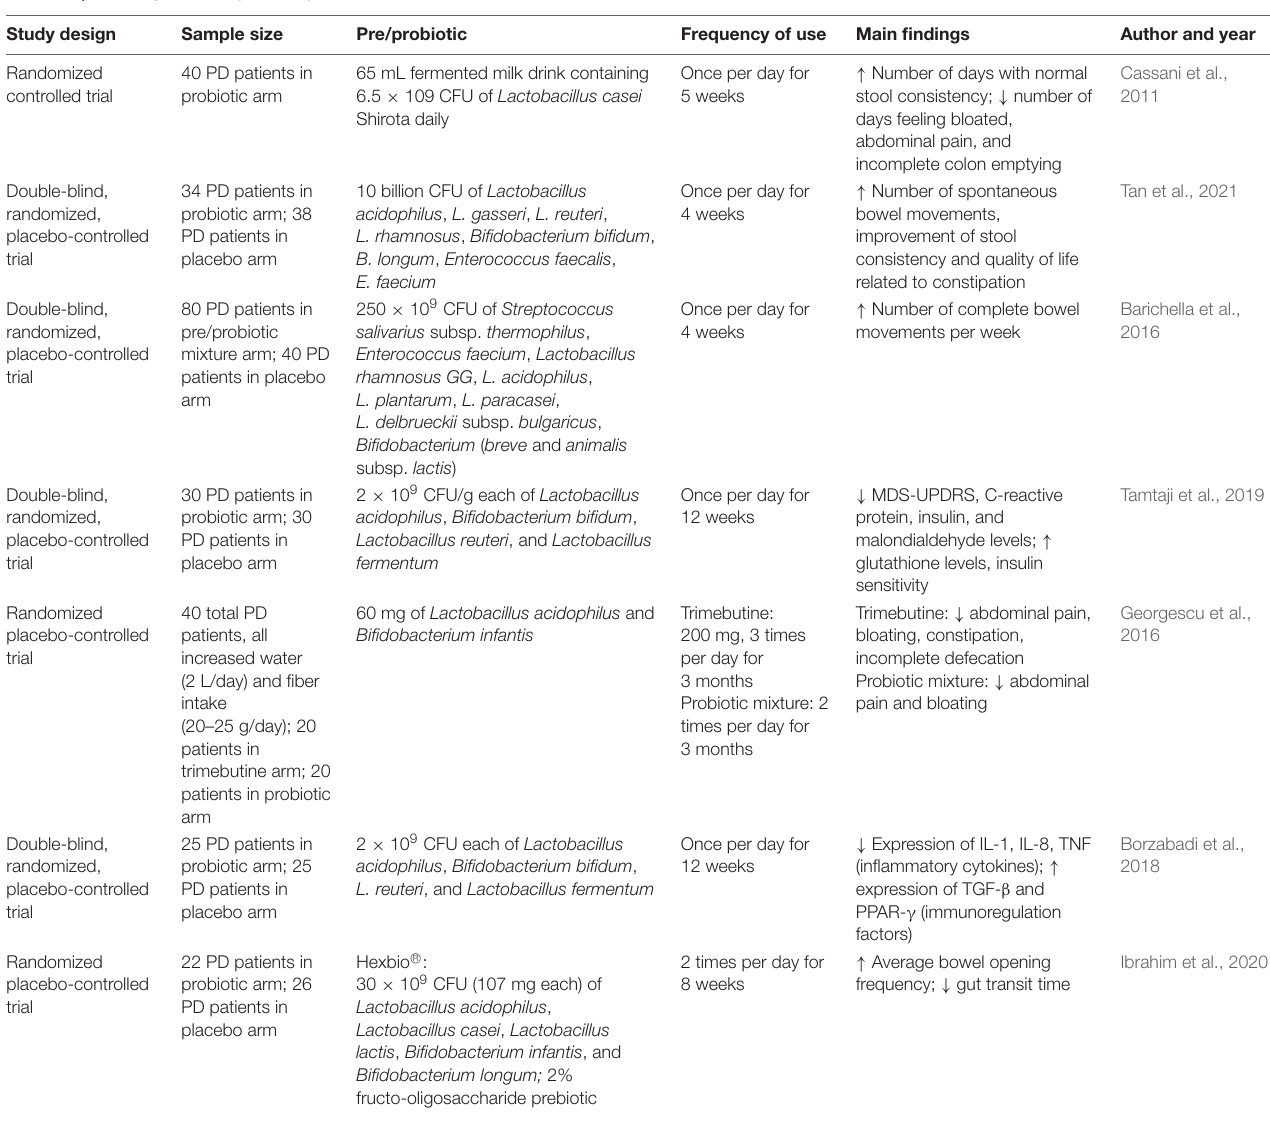
TABLE 1 | Summary of recent pre- and probiotic studies related to Parkinson’s disease in